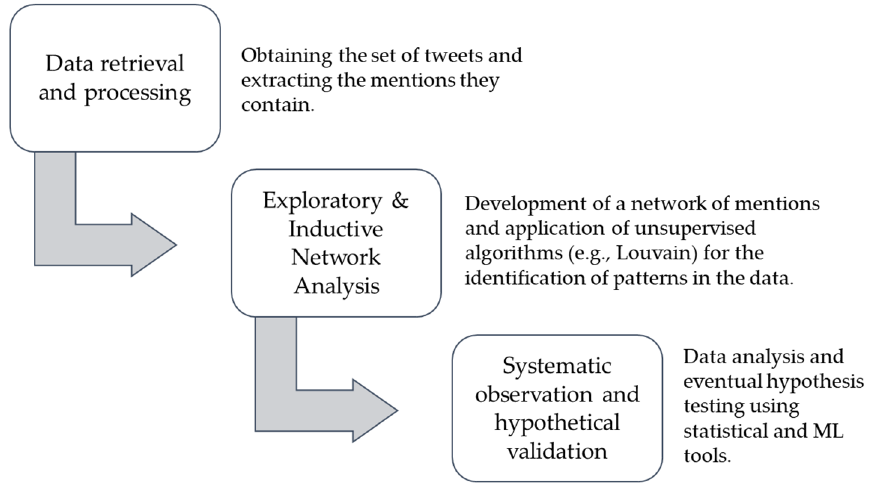
Figure 3. General workflow for the proposed methodology. Source: Own elaboration with Power Point.